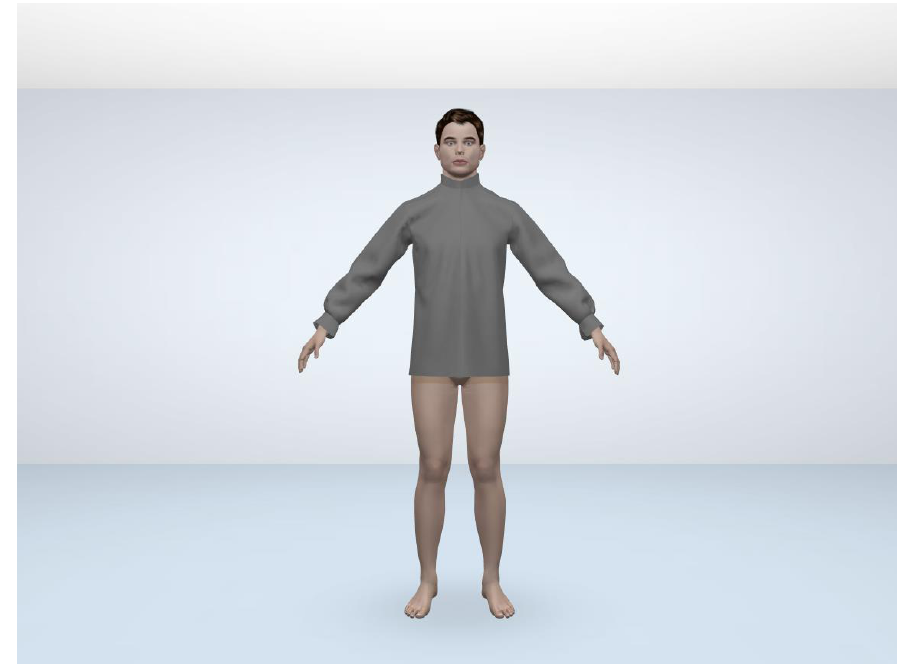
Figure 12. Shirt before adjustment.